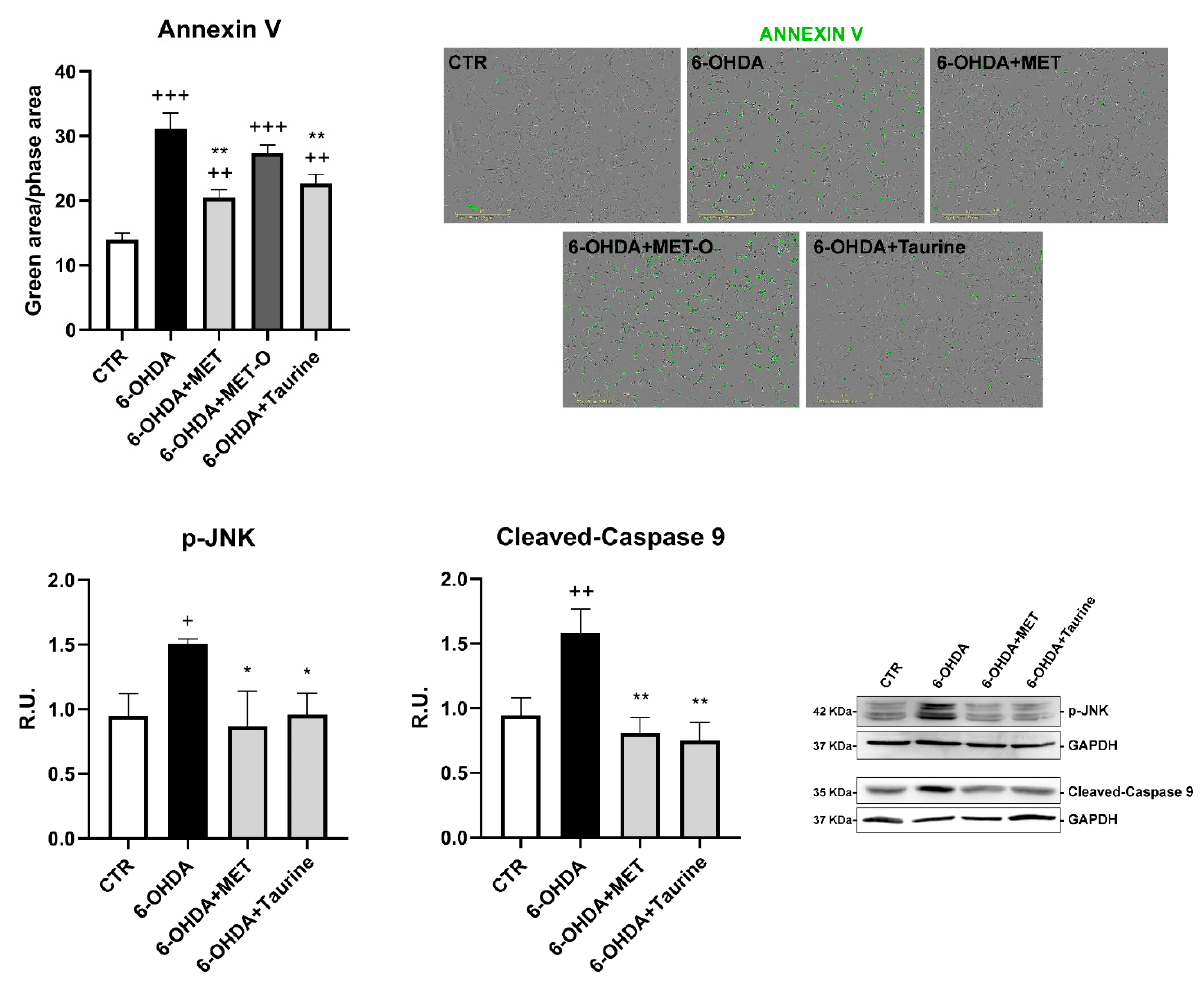
Figure 4. Apoptosis assayed by Annexin V in live-cell by Incucyte system and WB analysis for cleaved-caspase9 and p-JNK. A representative WB figure is shown. Data are mean ± SD of 3 different experiments. * p < 0.05, ** p < 0.005 vs. 6-OHDA; +++ p < 0.0001; ++ p < 0.005; + p < 0.05 vs. CTR.